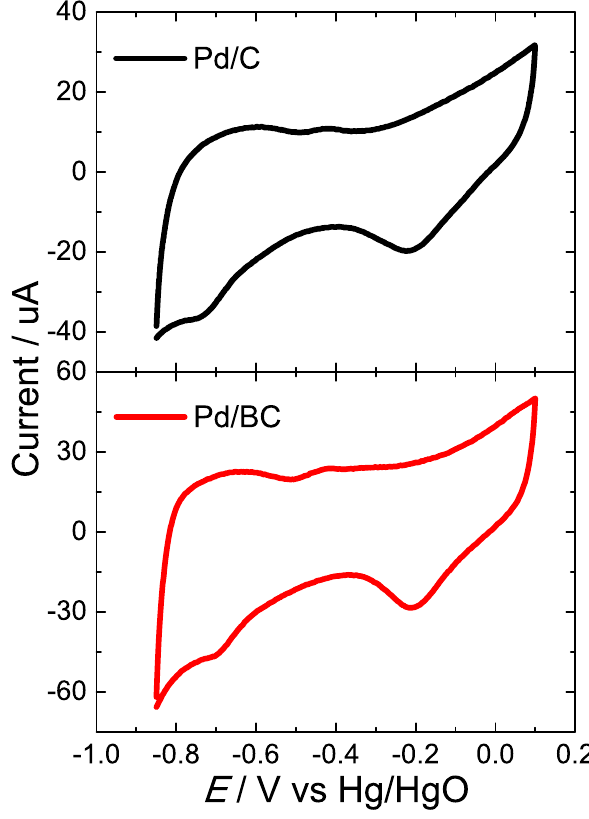
Fig. 5 Voltammograms of Pd/C and Pd/BC in 1 mol L −1 KOH at 20 mVs −1